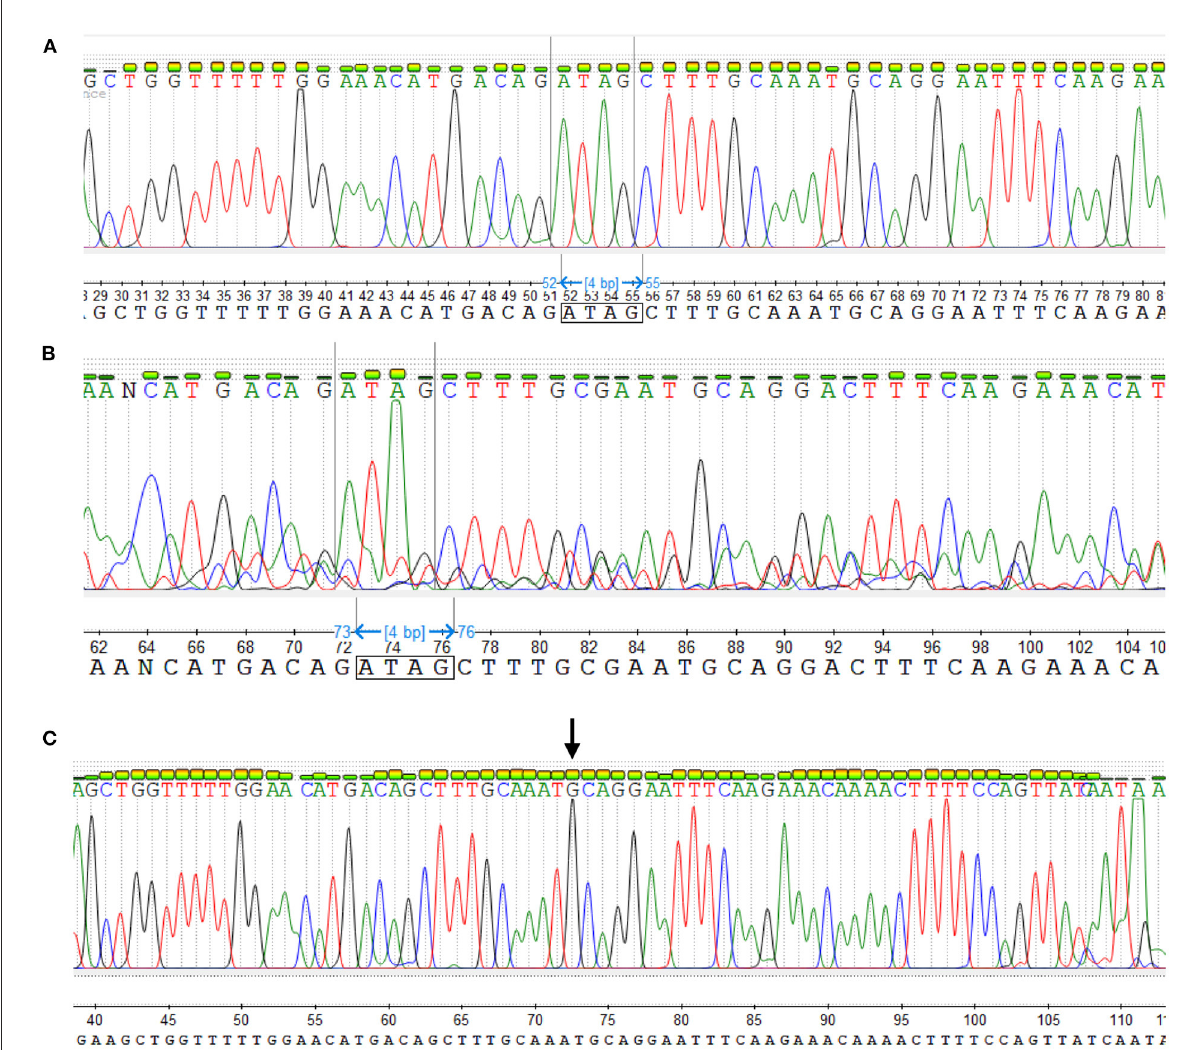
FIGURE2 Sequence of the three genotypes. (A) The wild-type genotype—neither of the two alleles contains the mutation, consequently their sequence is identical. Thus, the peak of each nucleotide is tall and distinct. (B) Heterozygous genotype—One complete allele and one allele carrying the deletion mutation, causing distortion of the sequence output from that point (two peaks). In this way, it can be seen a C peak from de mutant sequence under the A peak from the complete allele, a bigger T peak because of the overlap between the two alleles, and a second A peak much bigger than in the wildtype sequence, also because of the overlapping. (C) Homozygous mutant — In this case both alleles have the mutation, thus they are identical. The arrow indicates the position where the sequence is